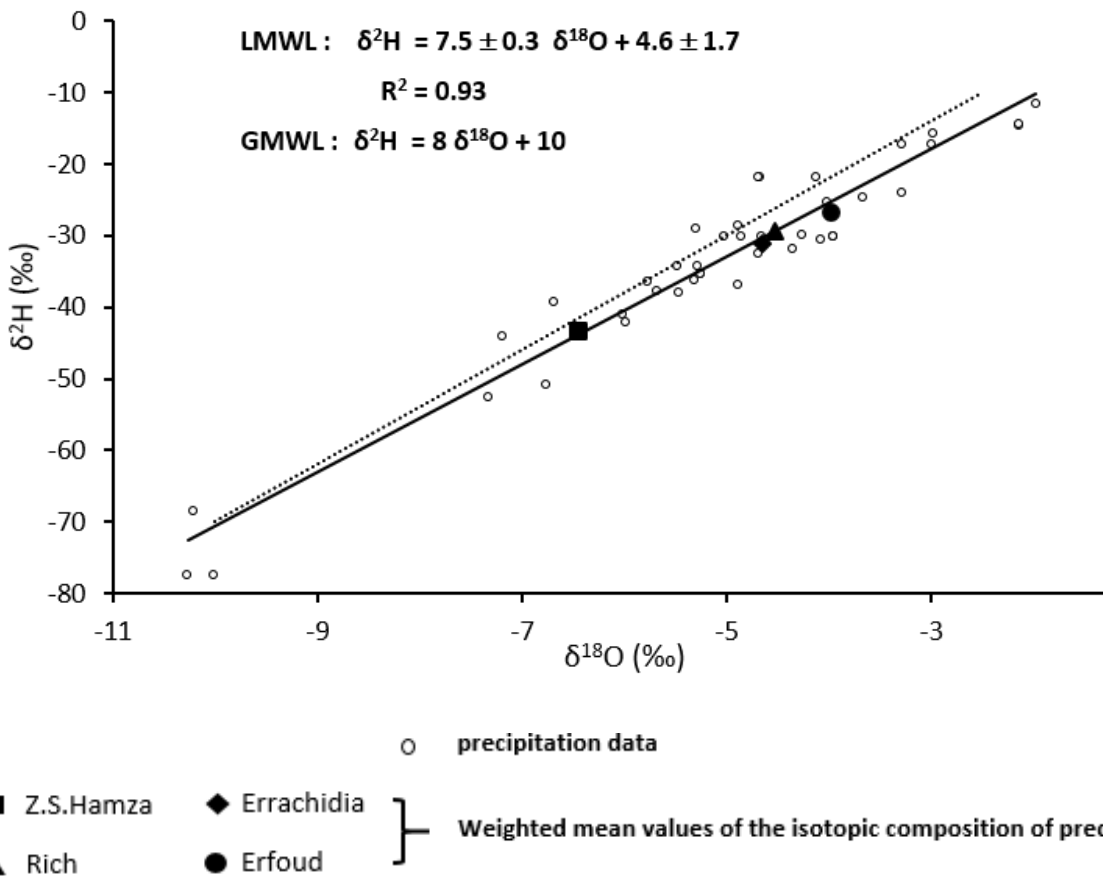
Figure 10. Relationship between δ 18 O and δ 2 H of the samples collected in the four studied stations with their weighted mean values during the period December 2019–November 2020. (Zaouia Sidi Hamza = 13 values; RCH = 14 values, Errachidia = 7 values; and Erfoud = 7 values). Local Meteoric Water Line (LMWL) and the Global Meteoric Water Line (GMWL, according to Craig 1961); R 2 = 0.93.